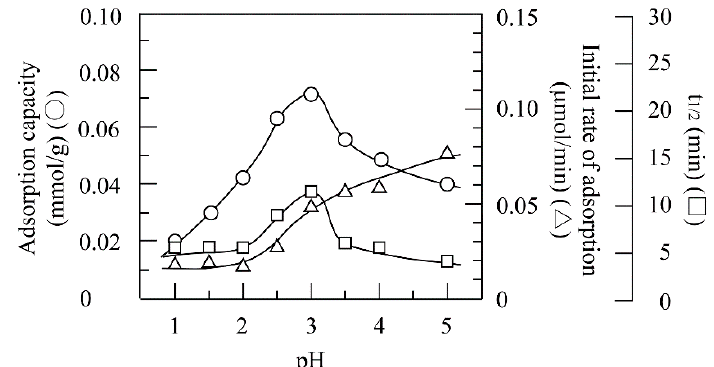
) and AEAPTES (cid:35) ) mmol/g in a (cid:51)